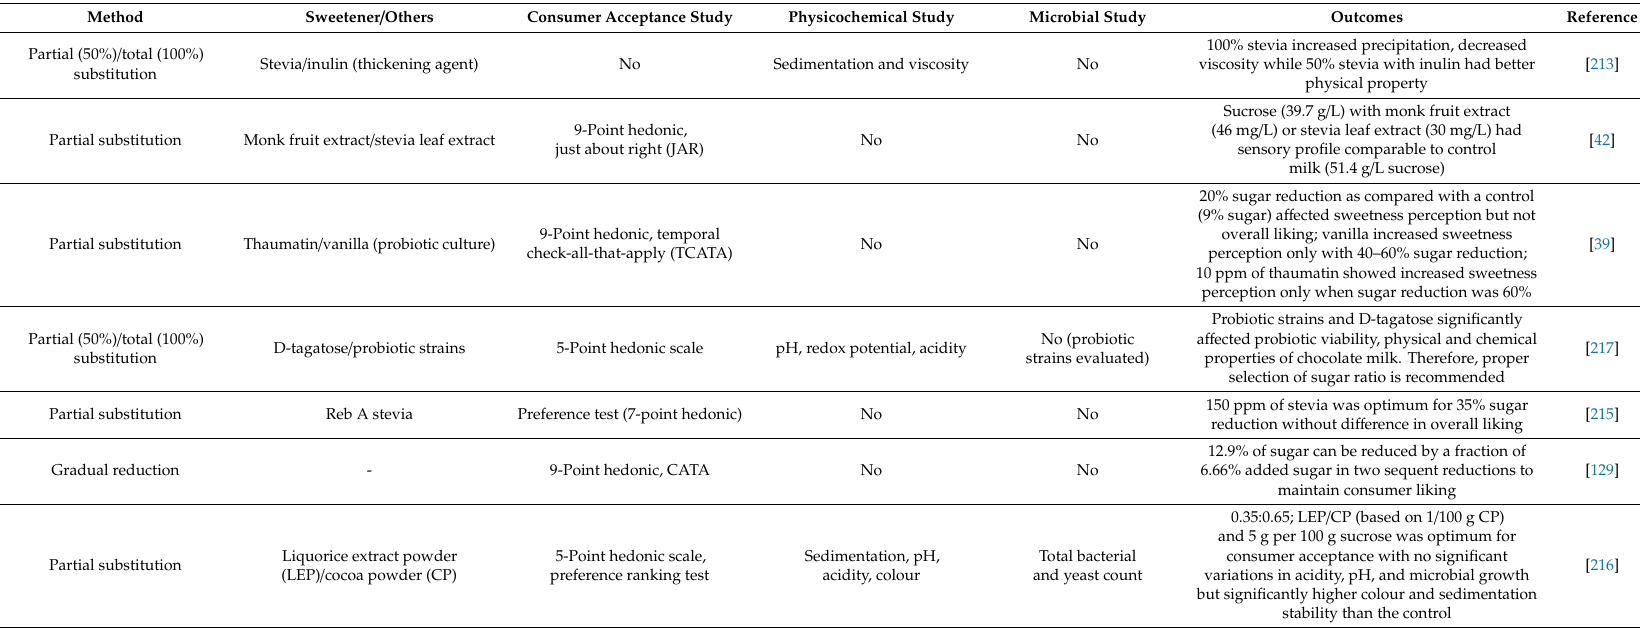
Table 5. Di ff erent sweeteners and methods used for sugar reduction in chocolate flavoured